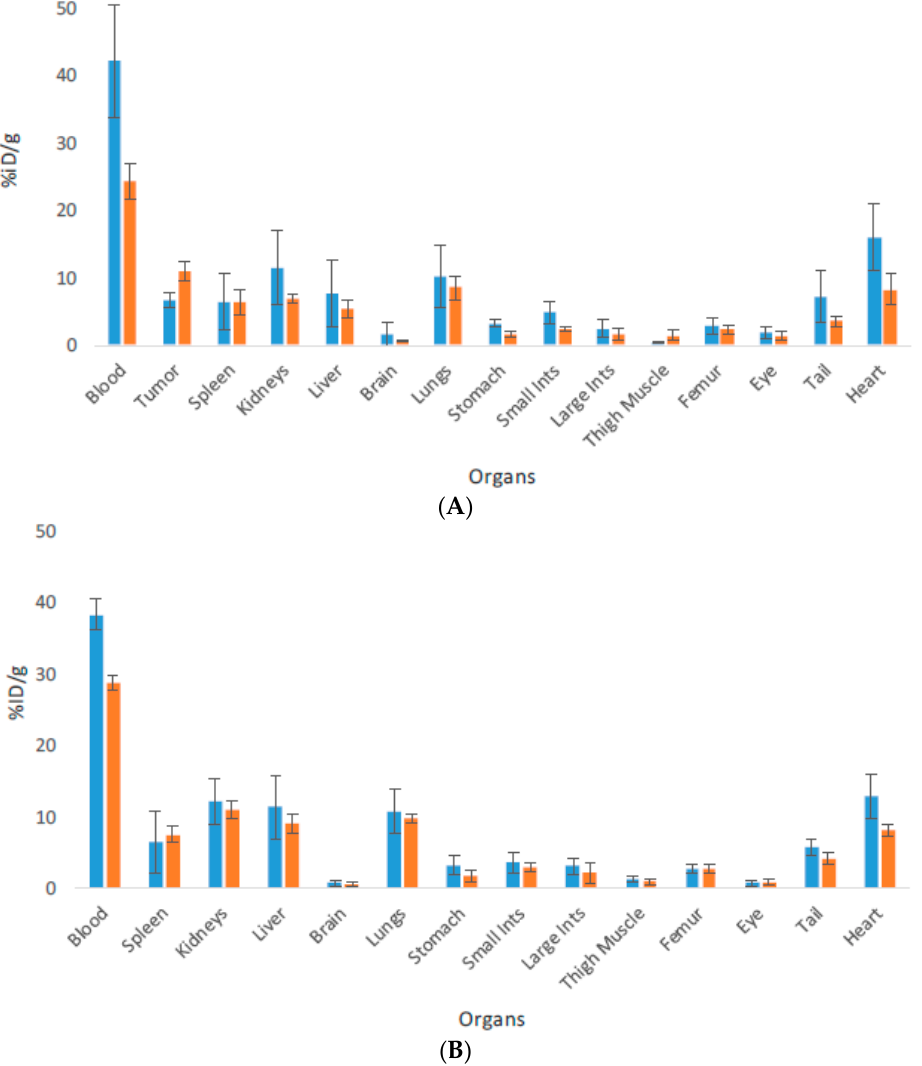
Figure 1. Biodistribution of 111 In-labeled antibodies Ab1 to melanin and isotype matching irrelevant control Ab2 in C57BL6 mice at 4 and 24 h after IV administration. ( A ) Ab1 antibody in B16F10 melanoma bearing mice; ( B ) Ab2 in healthy mice. Blue and orange bars represent 4 and 24 h time points, respectively. The error bars represent the SEM of sample groups of 4–5 mice.